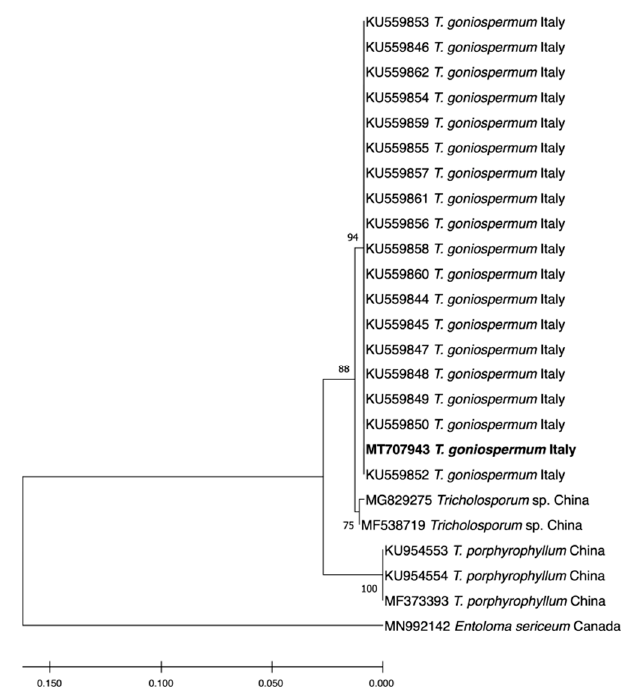
Figure 1. Maximum-likelihood (Tamura-Nei model) tree showing the phylogenetic position of the Tricholosporum goniospermum PeruMyc2084 isolate used in this study (corresponding to MT707943). We used sequences representing different Tricholosporum species and T. goniospermum samples. Both GenBank accession numbers and geographical origins are reported. Bootstrap values (expressed as percentages of 1000 replications) are shown at branch points.